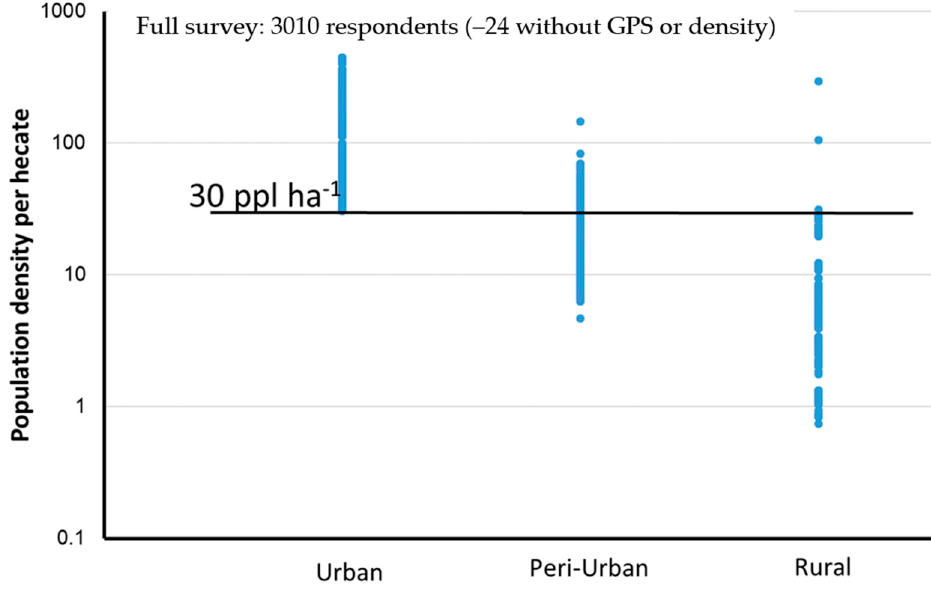
Figure A1. The local population density (from worldpop.com) of our survey respondents categorised by using our rural, peri-urban and urban divisions.